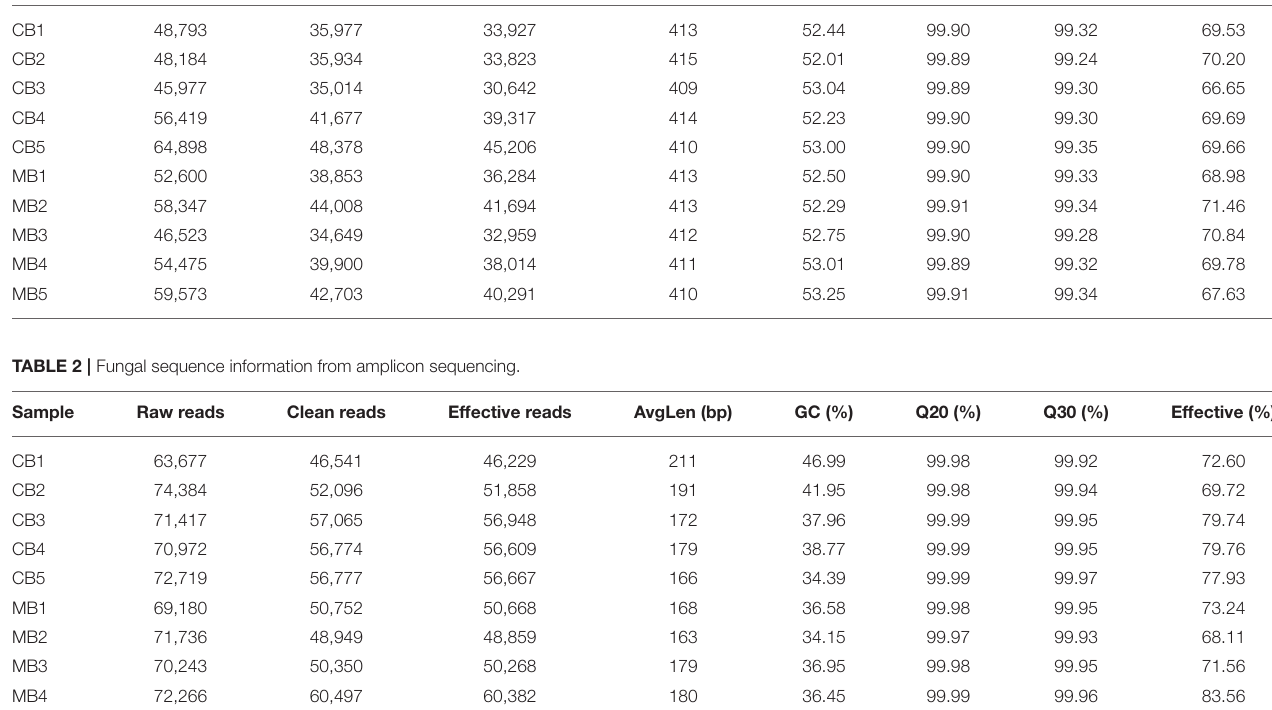
TABLE 1 | Bacterial sequence information from amplicon sequencing. Sample